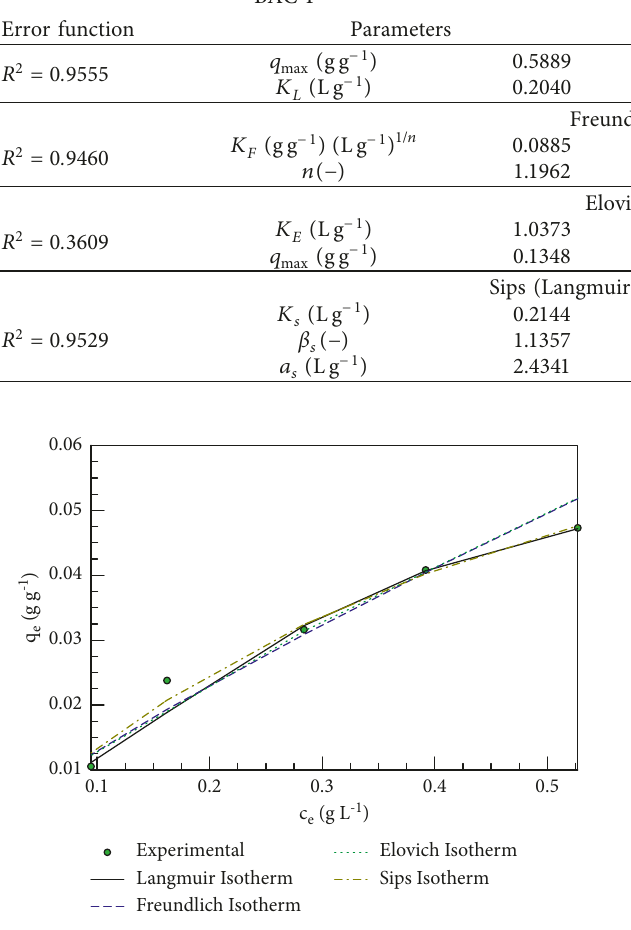
Figure 20: Adsorption isotherm models for Cu(II) ions adsorption onto the BAC-P adsorbent.